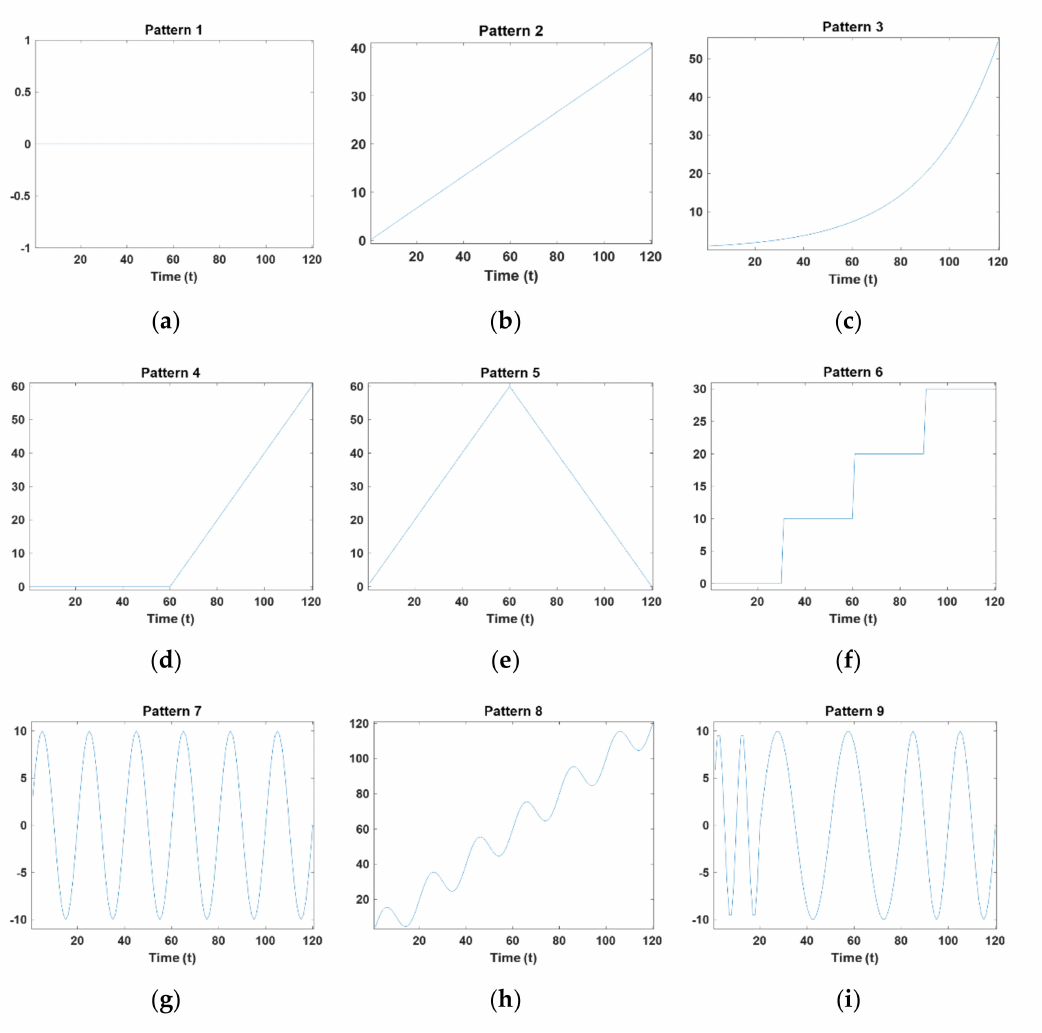
Figure 2. Baselines of nine time series